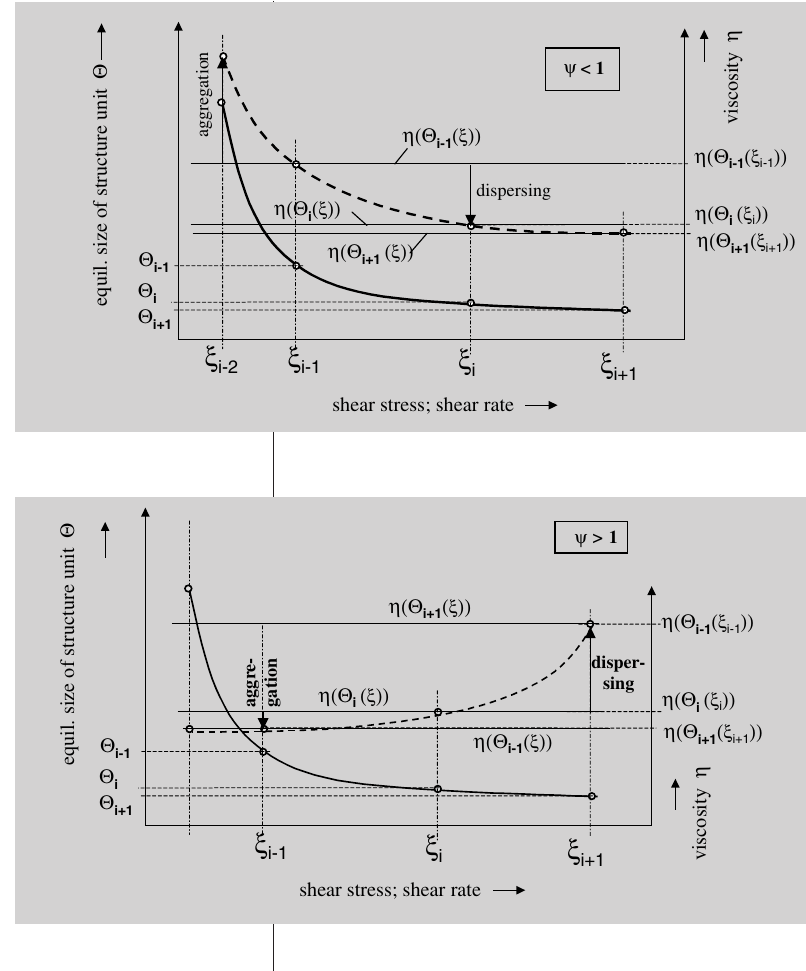
STRUCTURE VISCOSITY FUNCTIONS Structure-rheology relationship of suspensions with decreasing aggregate size at increasing shear rates/shear stresses and y < 1 (includes equilibrium viscosity function h ( Q *, x ), structure viscosity functions h ( Q , x ) and related structure function Q ( x )). Structure-rheology relationship of suspensions rates/shear stresses and y > 1.